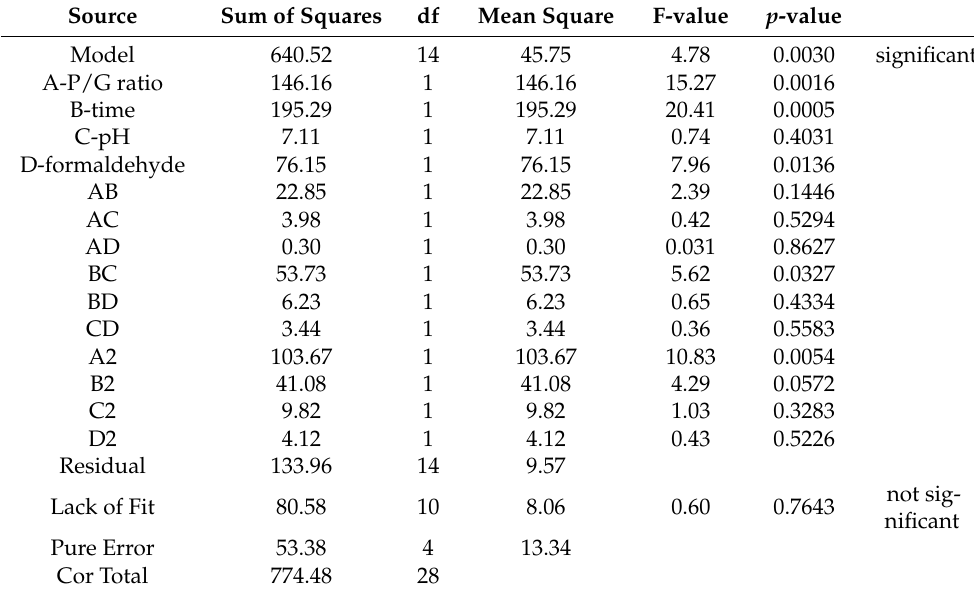
Table 4. Analysis of variance of response surface quadratic regression model.